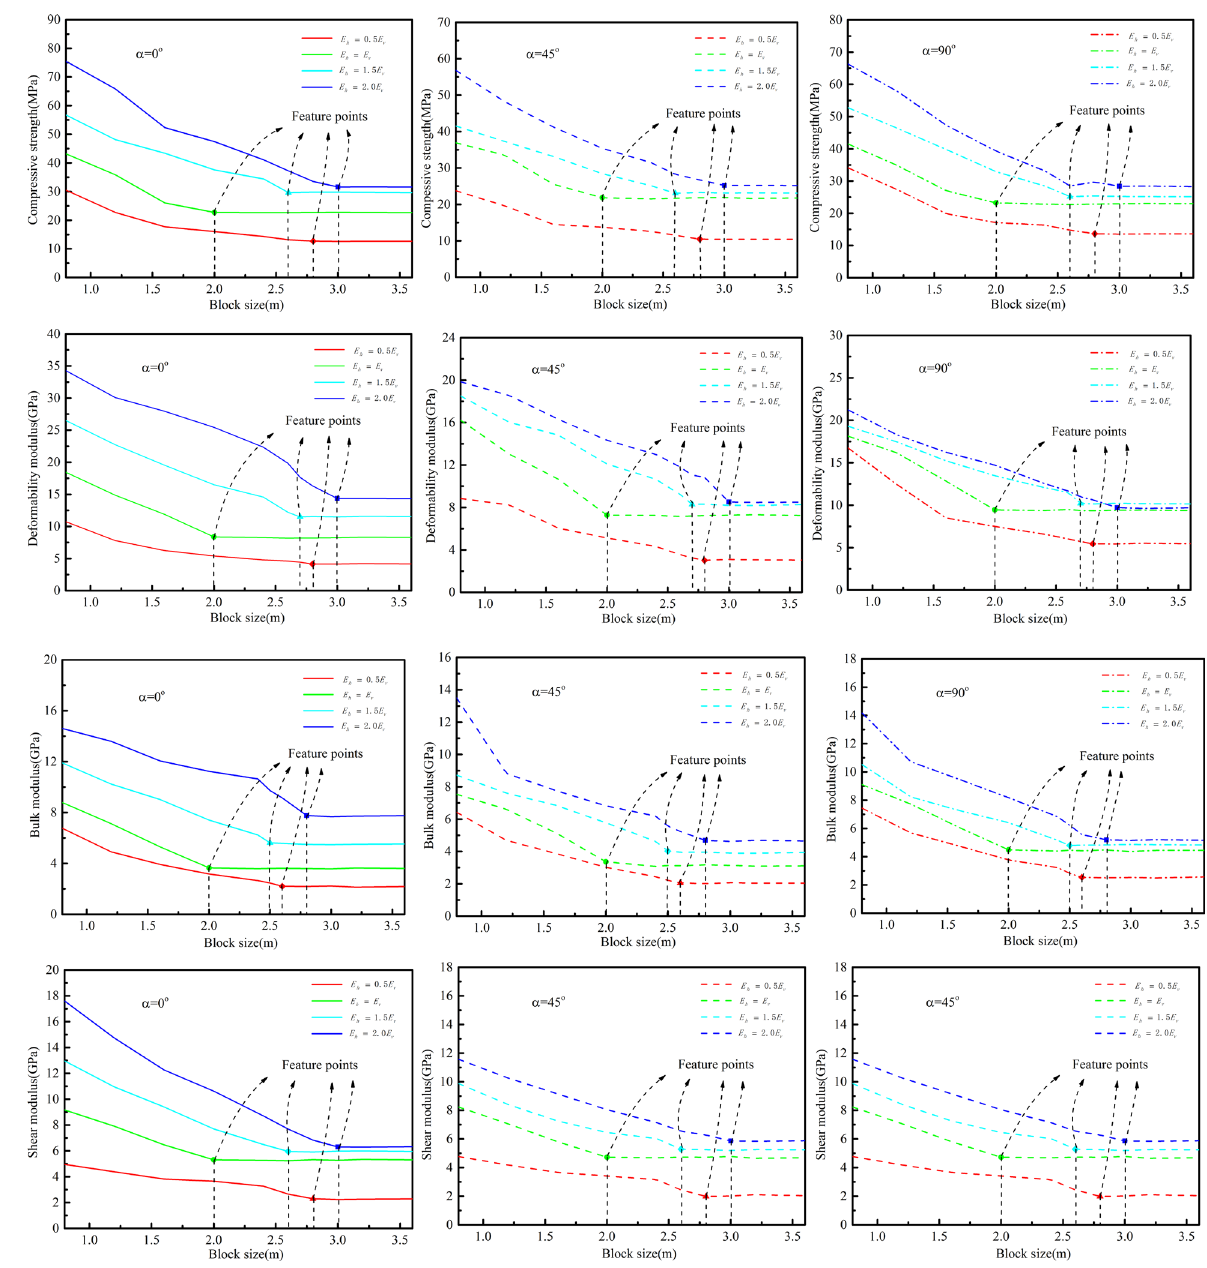
Fig. 10 Variations in mechanical parameters with respect to the anisotropy ratio and block size under the same bedding